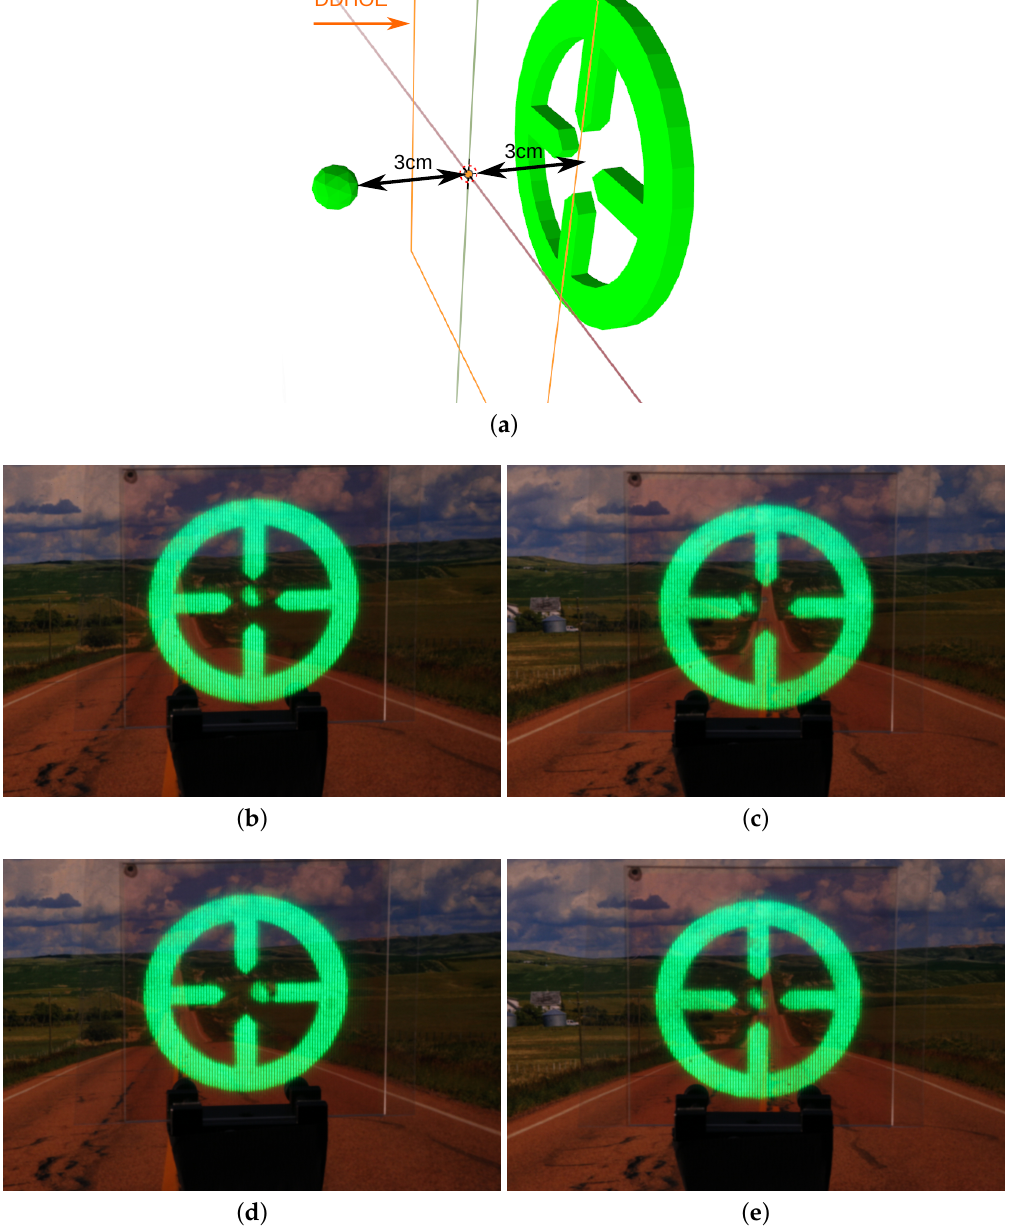
Figure 6. ( a ) the scene used in this experiment. Calibration without markers: ( b ) left view, ( c ) center view. Calibration with markers: ( d ) left view, ( e ) center